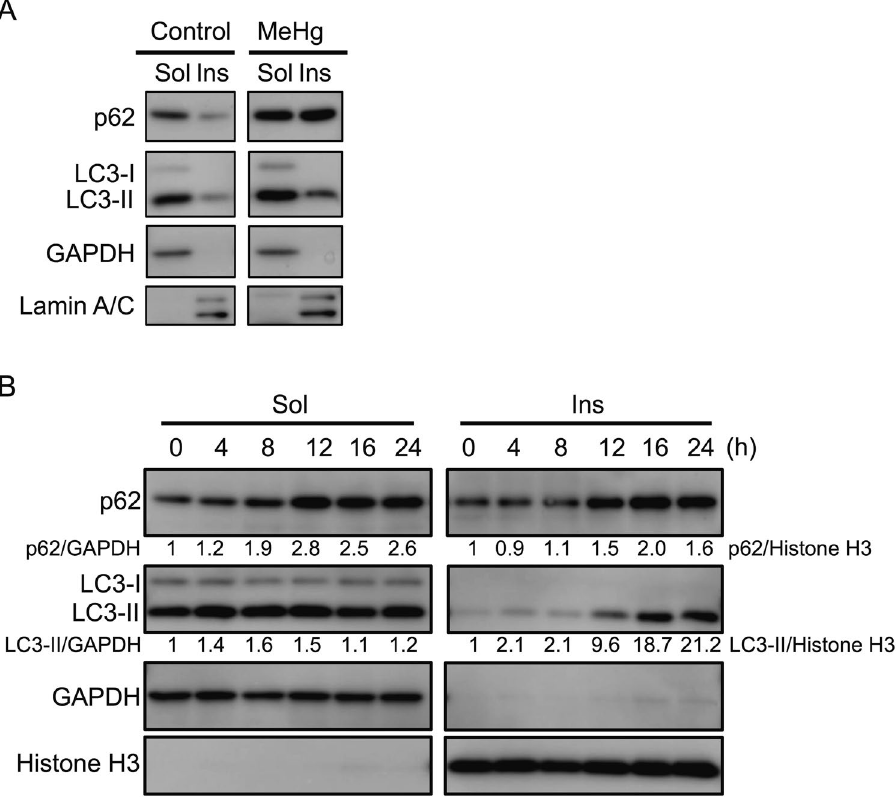
Figure 2. Methylmercury (MeHg) increases p62 protein levels in both the cytosol and aggregate fractions of mouse embryonic fibroblasts (MEFs). p62, LC3-I, and LC3-II protein levels in the soluble (Sol) and insoluble (Ins) fractions from wild-type (WT) MEFs. ( A ) Cells were treated with or without 1 µ M MeHg for 24 h. GAPDH and lamin A/C were used as loading controls. ( B ) Cells were treated with 1 µ M MeHg for 0–24 h. GAPDH and histone H3 were used as loading